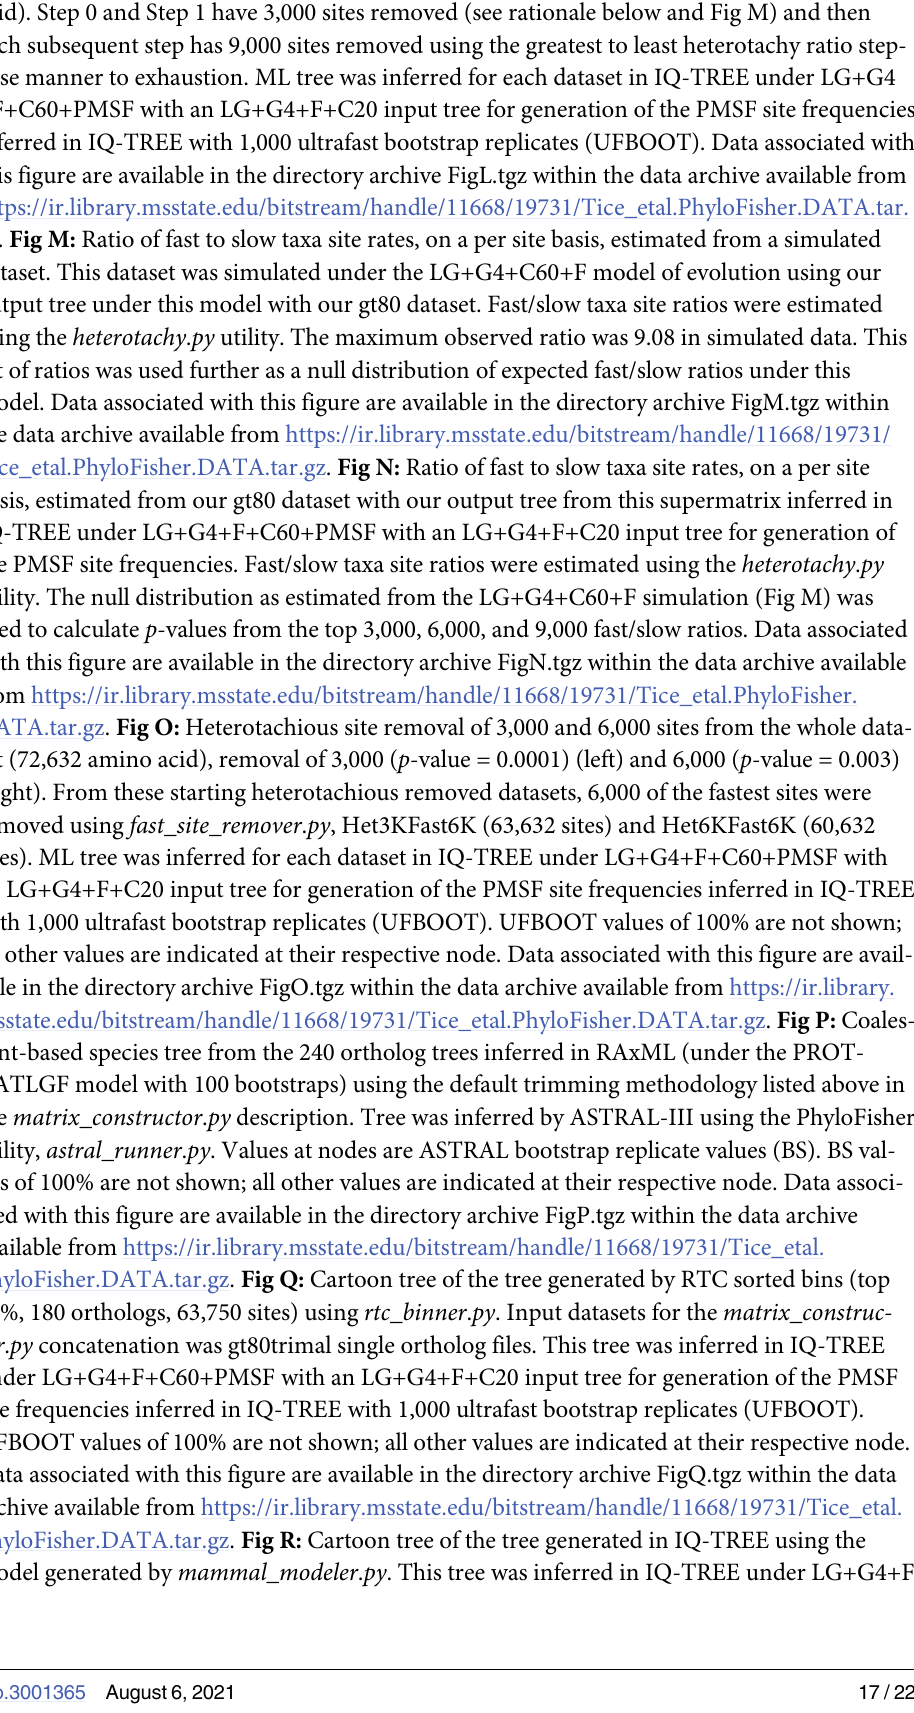
gz. Fig M: Ratio of fast to slow taxa site rates, on a per site basis, estimated from a simulated dataset. This dataset was simulated under the LG+G4+C60+F model of evolution using our output tree under this model with our gt80 dataset. Fast/slow taxa site ratios were estimated using the heterotachy . py utility. The maximum observed ratio was 9.08 in simulated data. This model. Data associated with this figure are available in the directory archive FigM.tgz